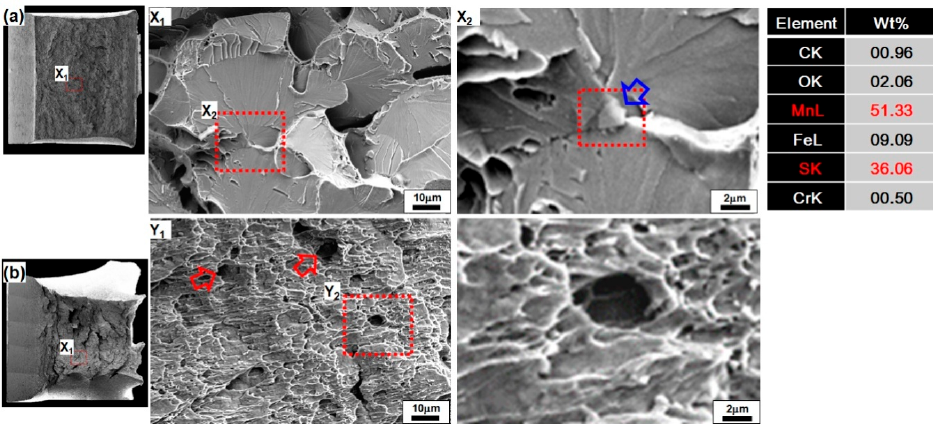
Figure 3. SEM observation of the fracture surface. ( a ) 28J; ( b ) 386J specimen.